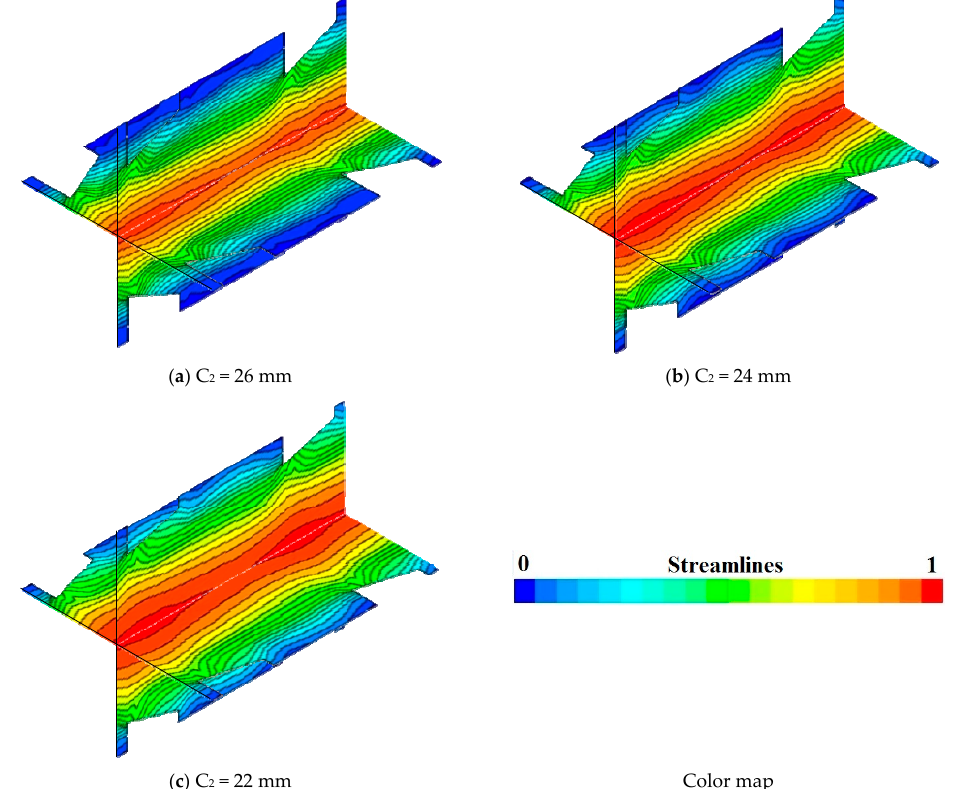
Figure 22. Streamlines for various configurations of Case C with different C 2 parameters at R = 15 mm, Re = 15,000, and 𝜑 = 0.5%. Figure 23 illustrates temperature contours for various configurations of Case C with different C 2 parameters at R = 15 mm, Re = 15,000, and 𝜑 = 0.5%. As can be seen, by changing parameter C 2, the temperature contours are affected and change. As parameter C 2 becomes longer, a reduction in the dark blue color in this section of the tube can be seen.